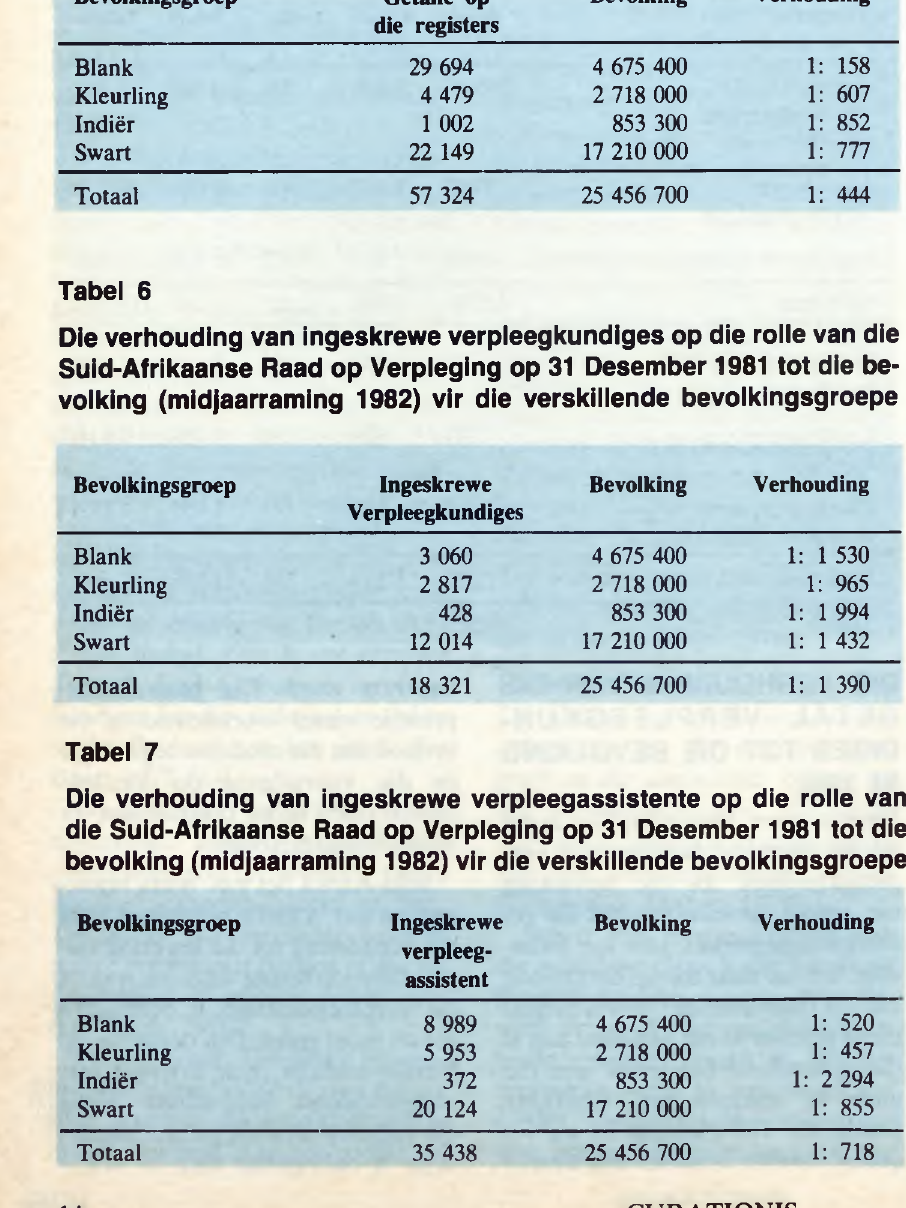
Die verhouding van geregistreerde verpleegkundiges en vroedvroue op die registers van die Suid-Afrikaanse Raad op Verpleging op 31 Desember 1981 tot die bevolking (midjaarraming 1982) vir die verskil­